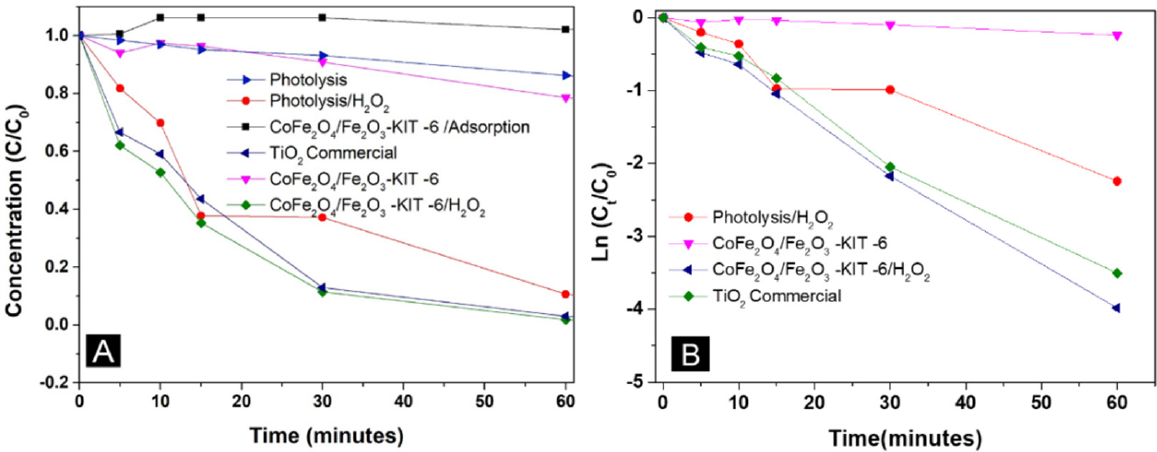
Figure 9. ( A ) Degradation of the ultra RGB red remazol dye in the presence of the CoFe 2 O 4 /Fe 2 O 3 – KIT-6 catalyst; ( B ) Pseudo-first order kinetics model. * C—Concentration at time t; C0—initial concentration.